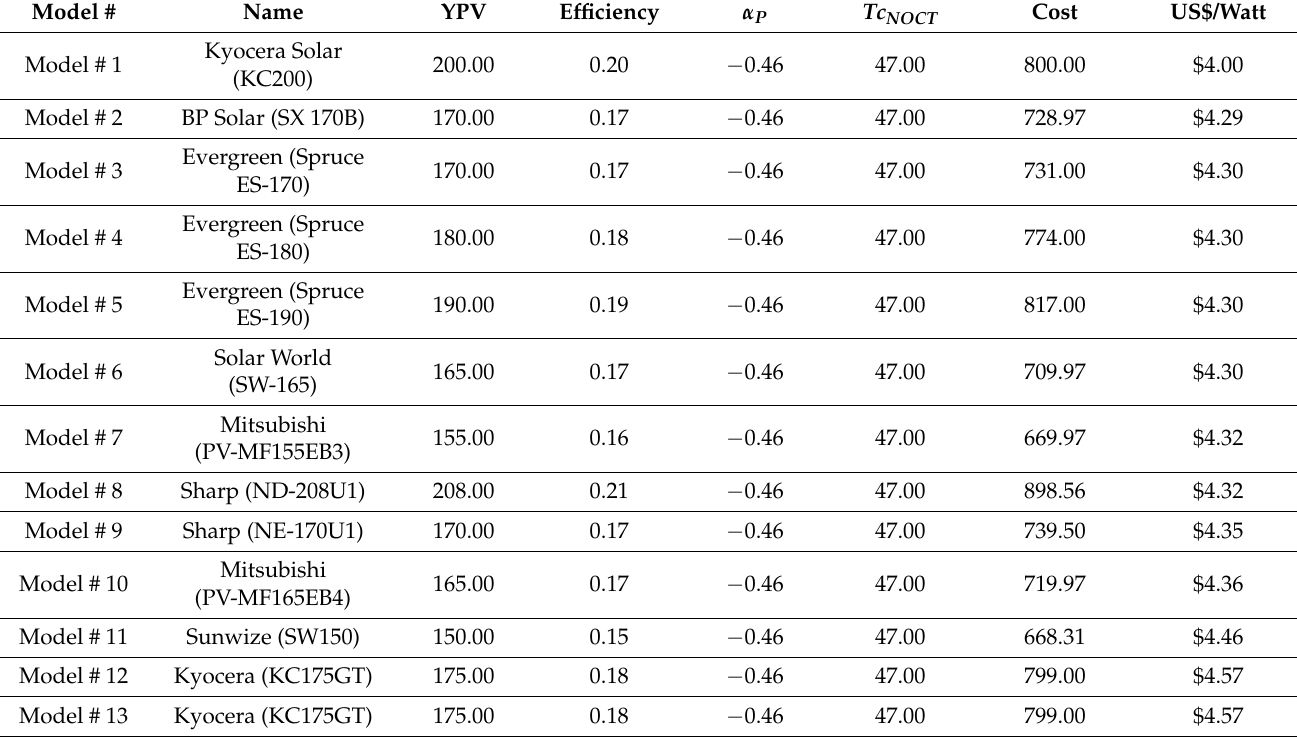
Table A1. PV panels models and information [54].